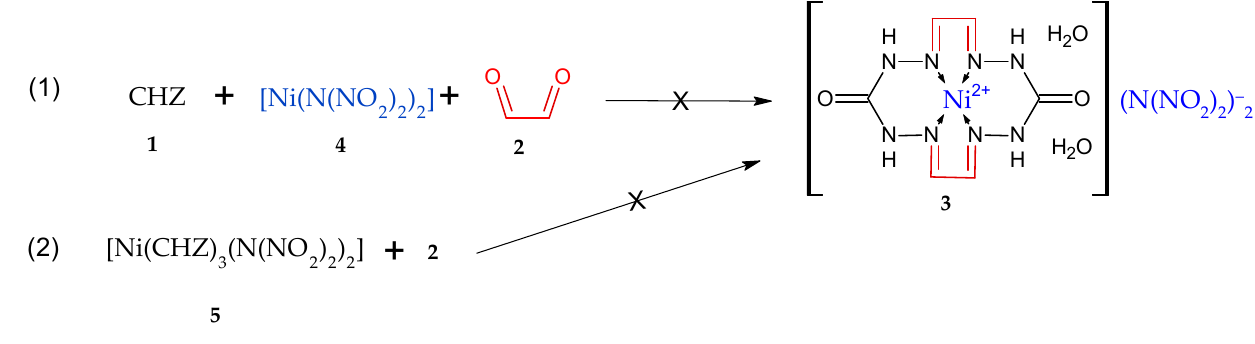
Figure 1. Synthesis of macrocycle ( 3 ) by reaction with glyoxal.